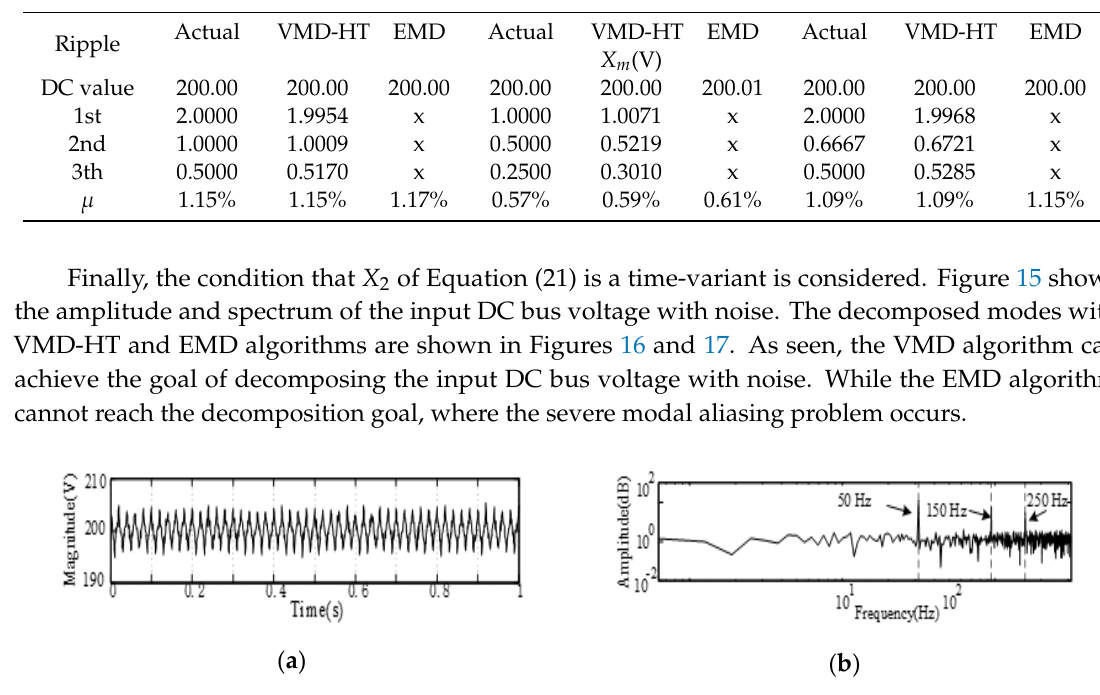
Figure 15. Performance of input signals under noise condition: ( a ) amplitude, ( b ) spectrum.